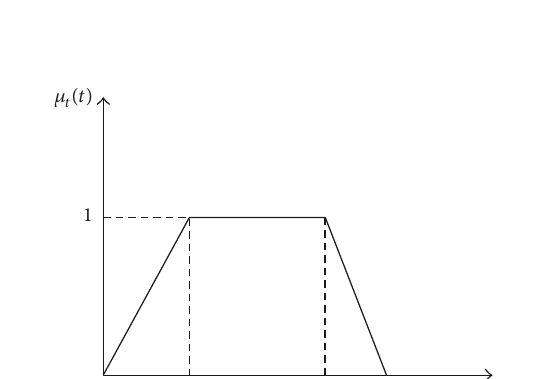
Figure 3: A cantilever tube.